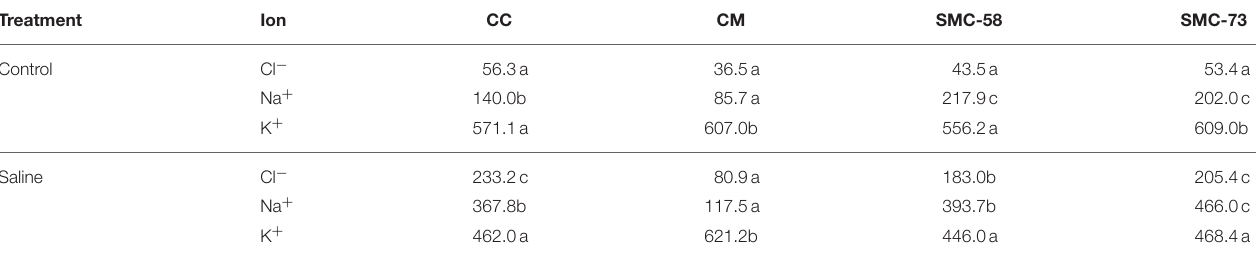
Values are the mean of 3 plants (n = 3). Different letters in each line indicate significant differences for P ≤ 0.05 at Duncan’s multiple range test. Plants were cultivated in a greenhouse for 20 days, either in saline (40mM NaCl) or control conditions.